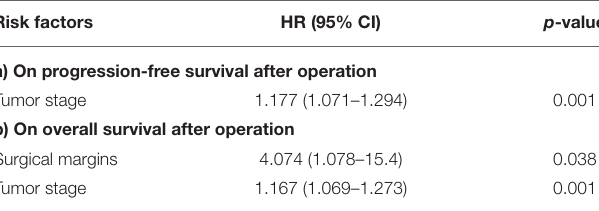
TABLE 5 | Multivariate analyses of the effect of clinicopathological